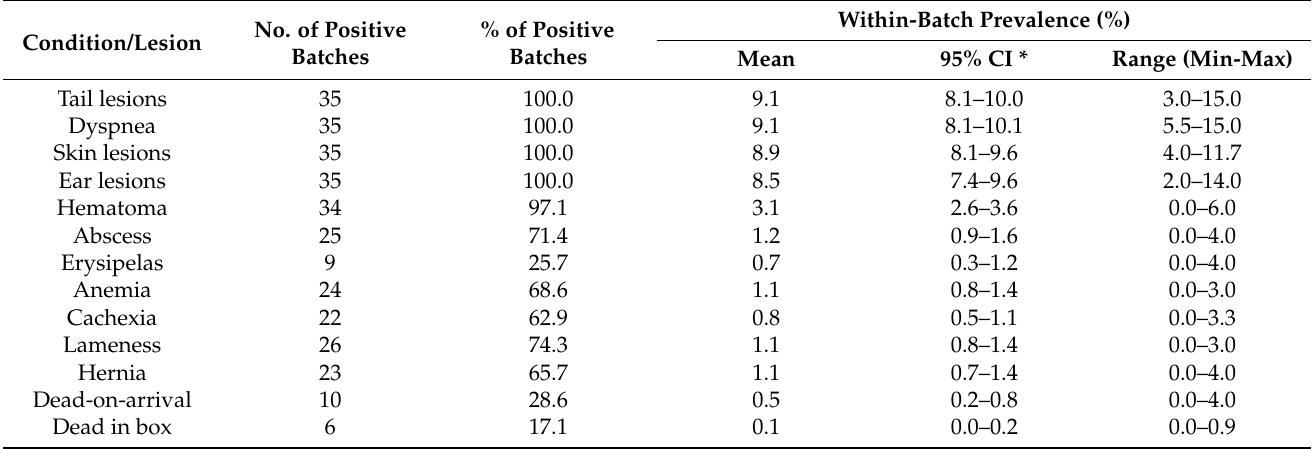
Table 2. Number of positive batches and within-batch prevalence of recorded ante-mortem condi- tions/lesions and within-batch mortality during transport of slaughtered pigs ( N = 35 batches).